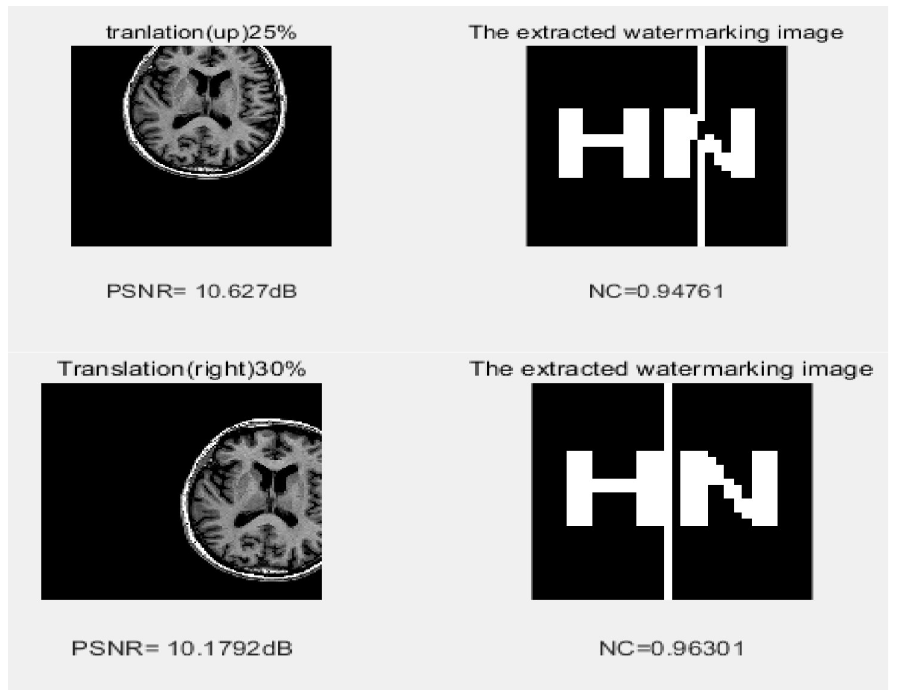
Fig 12. The impact of 25% UP and 30% translation attack on the